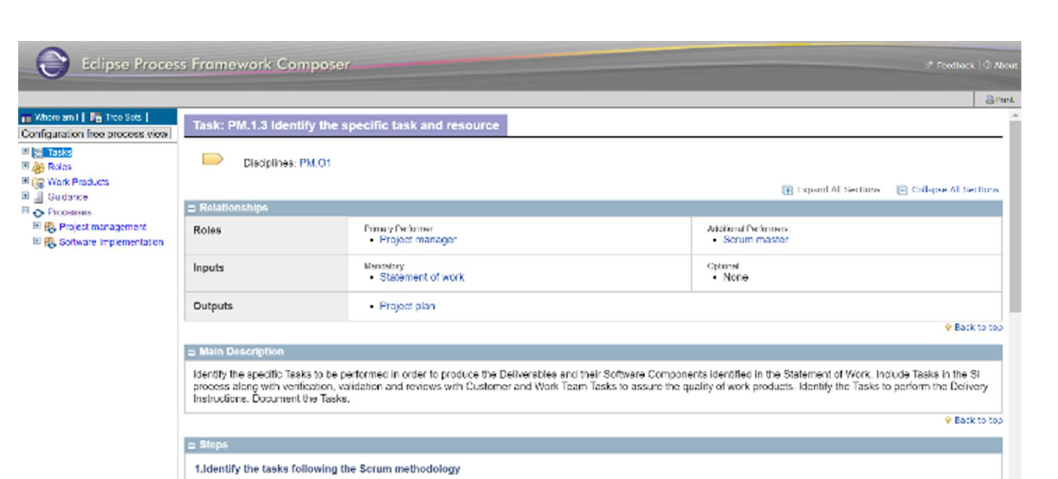
Figure 3. Example of the Eclipse Process Framework (EPF) Composer interface .